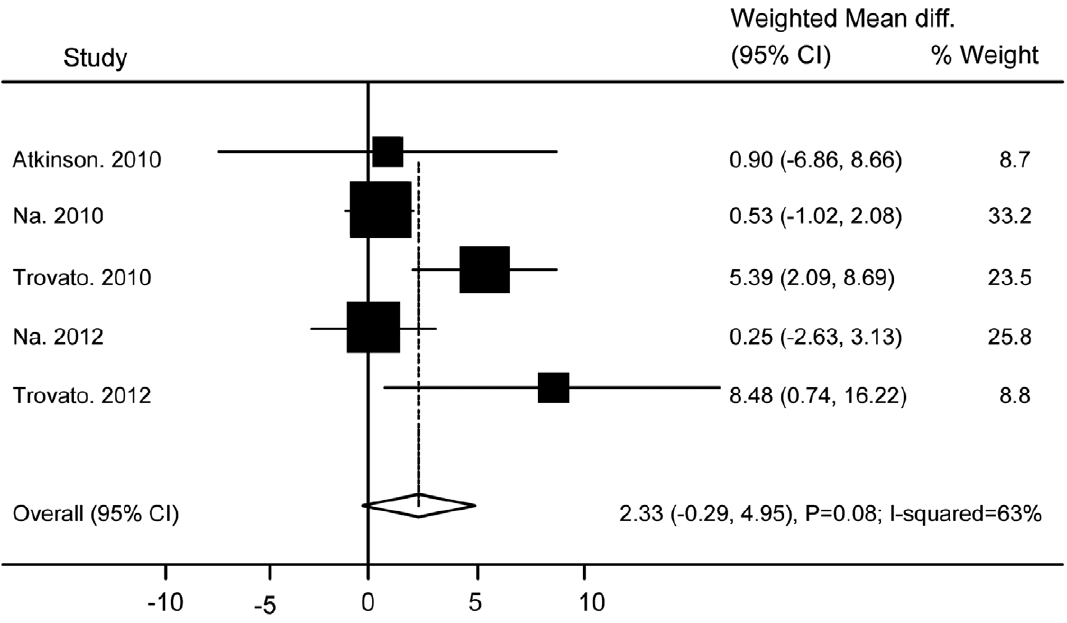
Figure 7. Association of Ad36 with Blood Glucose.